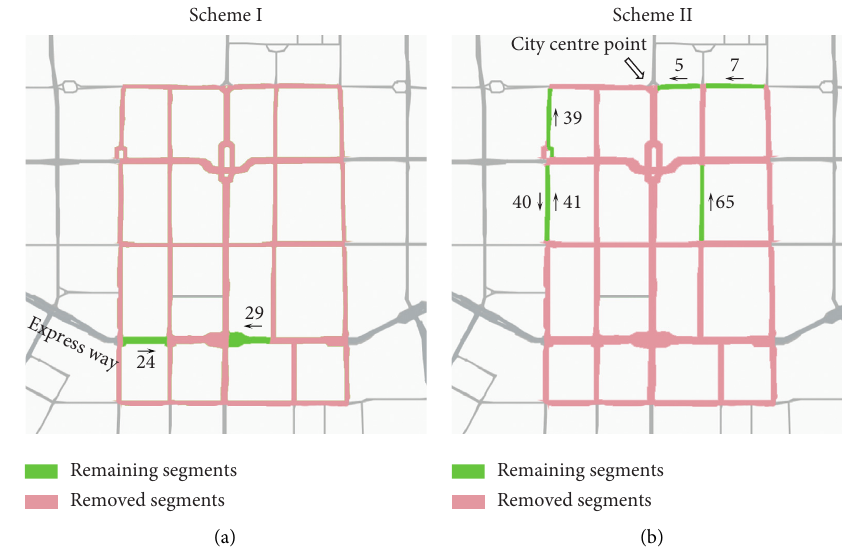
Figure 5: Results of critical segments